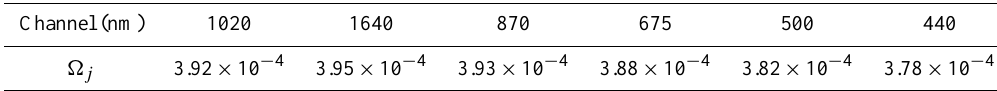
Table 2. CE-1 solid angle (in steradians) determined with daytime